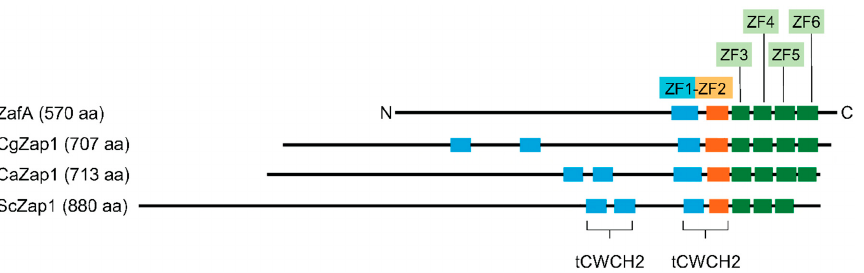
Figure 1. Schematic representation of the transcriptional regulators of zinc homeostasis from Aspergillus fumigatus (ZafA), Cryptococcus gattii (CgZap1), Candida albicans (CaZap1) and Saccharomyces cerevisiae (ScZap1). Green boxes indicate canonical zinc finger (ZF) domains of the C2H2-type. Blue and orange boxes indicate ZFs of the CWCH2-type. These ZFs are typically arranged in pairs forming tandem CWCH2 motifs (tCWCH2). The ZF of the CWCH2-type that is presumably able to bind DNA is indicated as an orange box. Protein sequences were aligned taking as reference the ZF of the C2H2-type located towards the N-terminus in ZafA (i.e., ZF3).